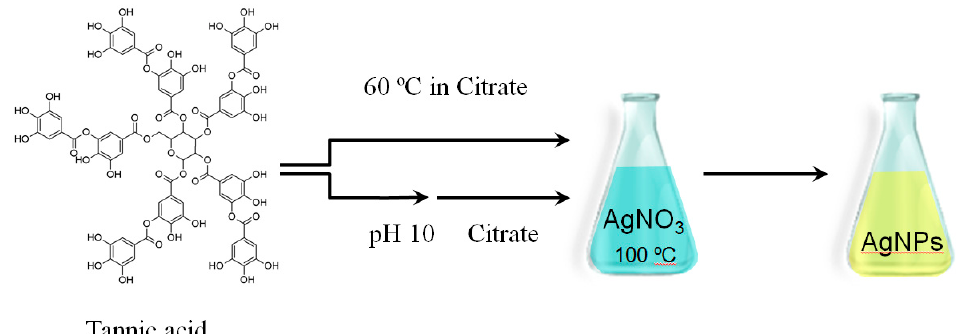
Figure 4. Synthesis of AgNPs by thermal preconditioning of TA in citrate at 60 ◦ C from 0, 15, 45 and 90 to 180 min and by pH preconditioning of TA at pH 10: the TA/citrate solution was then added to a boiling solution of AgNO 3 , and AgNPs were formed.